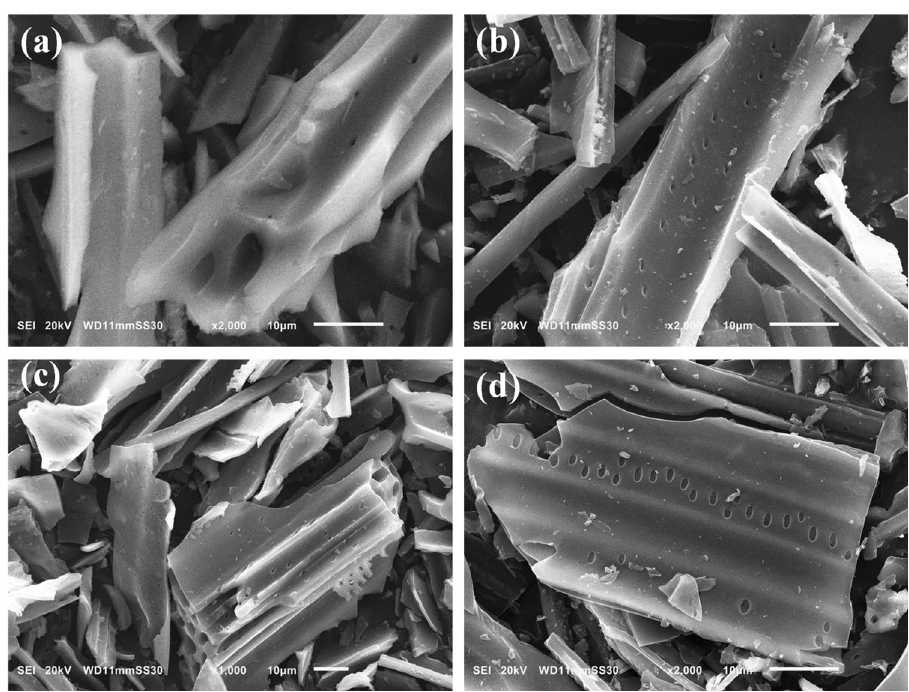
Figure 4. SEM images of ( a ) BU_car, ( b ) BU_AC_H 2 O, ( c ) BU_AC_K 2 CO 3 , and, ( d )